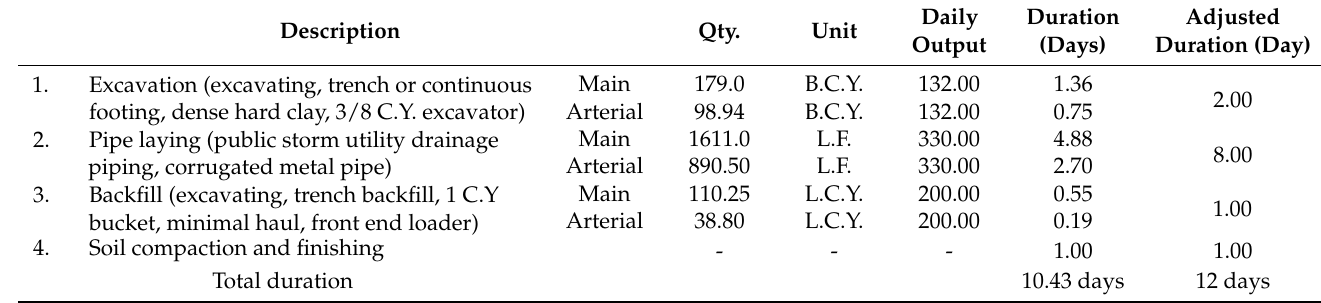
Table 6. Technical/design analysis–duration of each activity for French drain alternative.